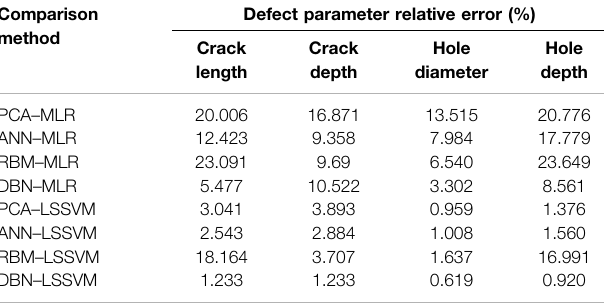
TABLE5| Meanrelativeerrorofthedefectevaluationofthecomparisonmethods. Comparison method